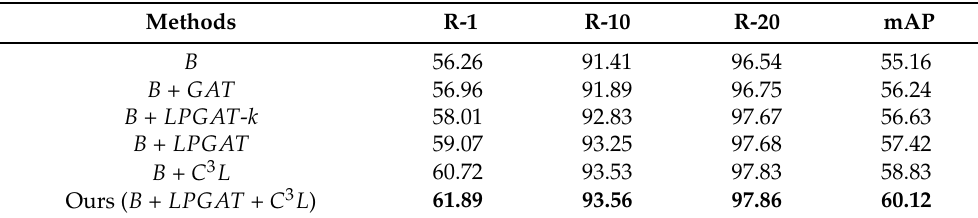
Table 3. Ablation studies on SYSU-MM01 on the all-search setting. The bold indicates the best result. Methods R-1 R-10